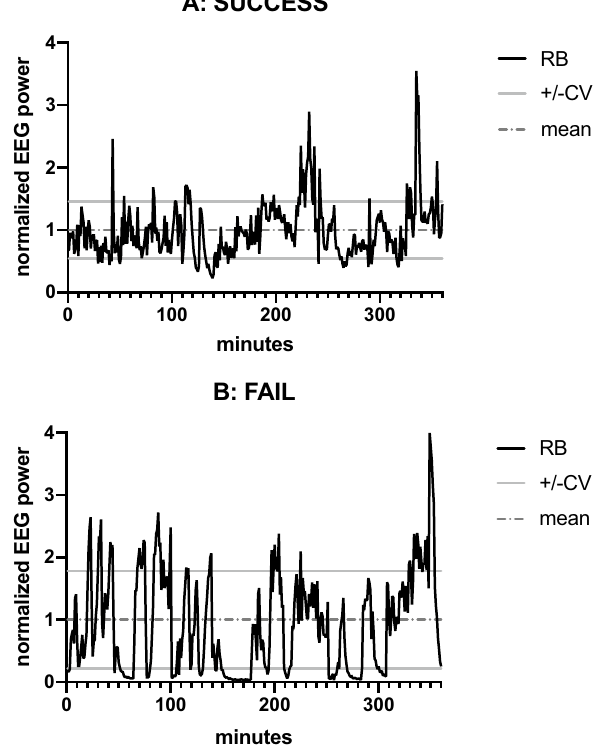
Figure 1. Examples of normalized relative beta EEG power values over time in two patients before extubation. ( A ) Patient 52, diagnosed with status epilepticus, successful extubation after 107 h of MV, CV = 0.46. ( B ) Patient 48, diagnosed with intracerebral hemorrhage in the left hemisphere, extubation after 156 h of MV, afterwards need for NIV and after 2 days need for reintubation because of insufficient vigilance and hypoxemia, CV = 0.78. CV = coefficient of variation, EEG = electroencephalogram, MV = mechanical ventilation, NIV = non-invasive ventilation, RB = relative beta.